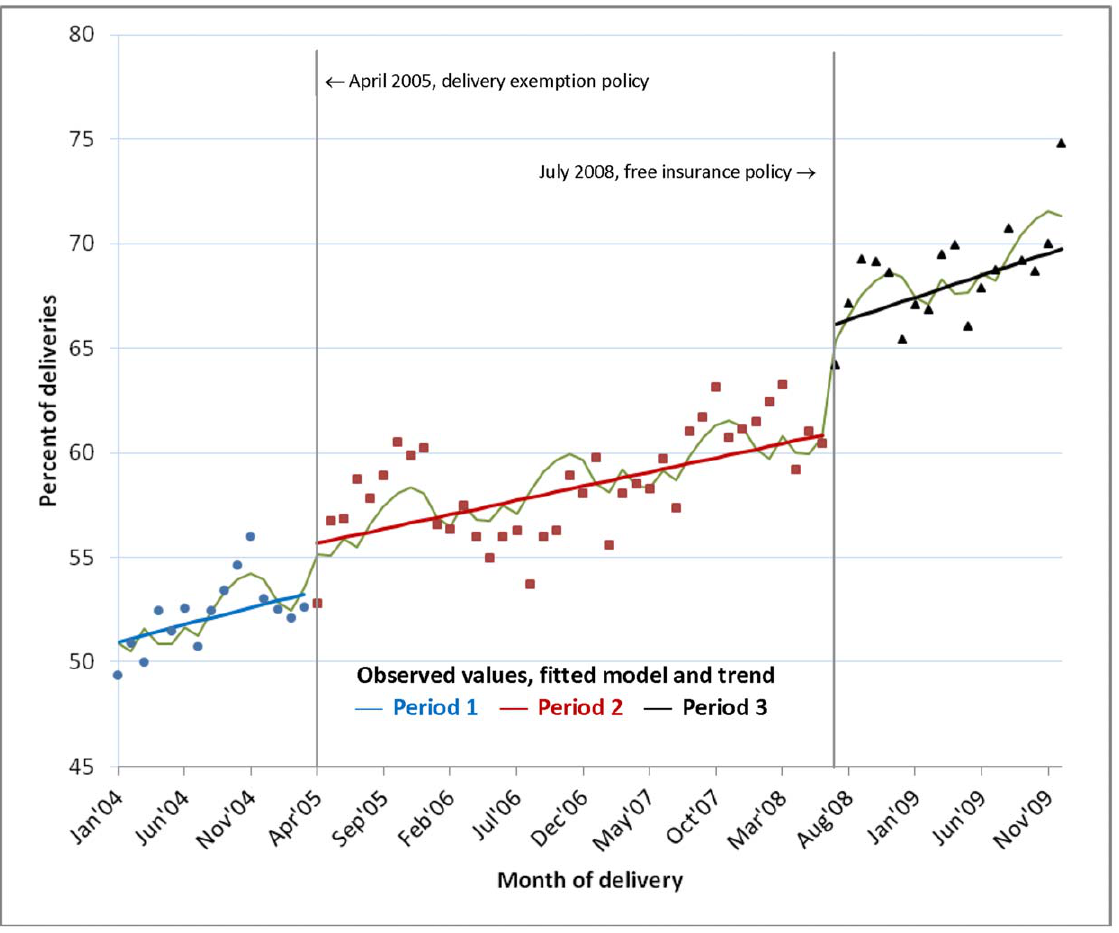
Figure 2. Facility deliveries, January 2004–December 2009: observed values, fitted model and trend. Figure shows the percentage of deliveries occurring in a facility each month in each policy period: observed values (dots), fitted model (wavy line) and trend (straight lines).